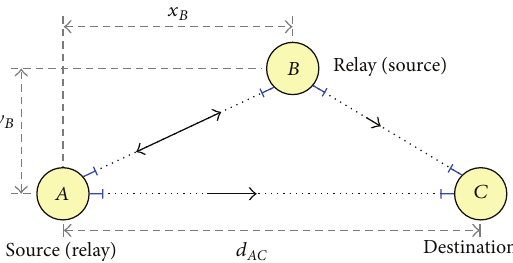
Figure 1: Block diagram of the considered 3-way FSO communica- tion